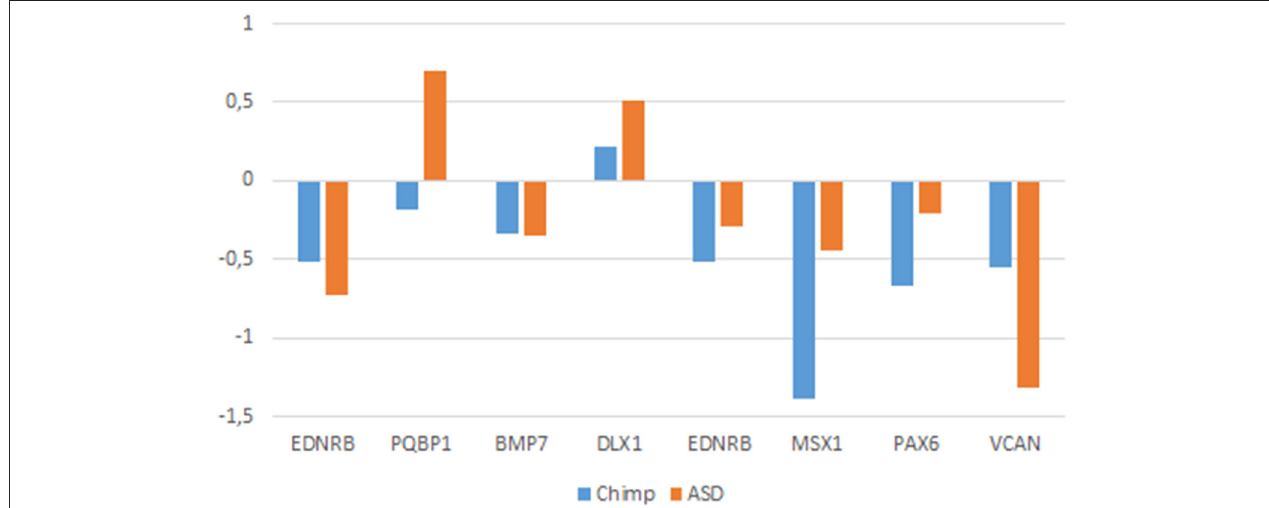
FIGURE 6 | Comparative expression profiles in chimpanzees and subjects with ASD of candidate genes. Data were obtained from microarray expression datasets available on the Gene Expression Omnibus database (GEO datasets, http://www.ncbi.nlm.nih.gov/gds): GSE28521 (Voineagu et al., 2011) for the temporal and frontal cortices, and GSE38322 ( Ginsberg et al., 2012) for the cerebellum of subjects with ASD; GSE22569 (Somel et al., 2011; Liu et al., 2012) for the cerebellum, GSE18142 (Konopka et al., 2009) for the frontal cortex, and GSE7540 (Cáceres et al., 2003) for the temporal cortex of chimps. Data are shown as log transformation of fold changes (logFC) between patients and corresponding controls. Only genes showing statistically significant ( p < 0.05) differential expression were considered. Additional details may be found in the Supplemental information file. Note that the plot is intended to display the overall trend of gene expression, given that the relative expression values (i.e., logFC) were obtained from comparative analyses performed on different datasets (based on different designs, samples, and